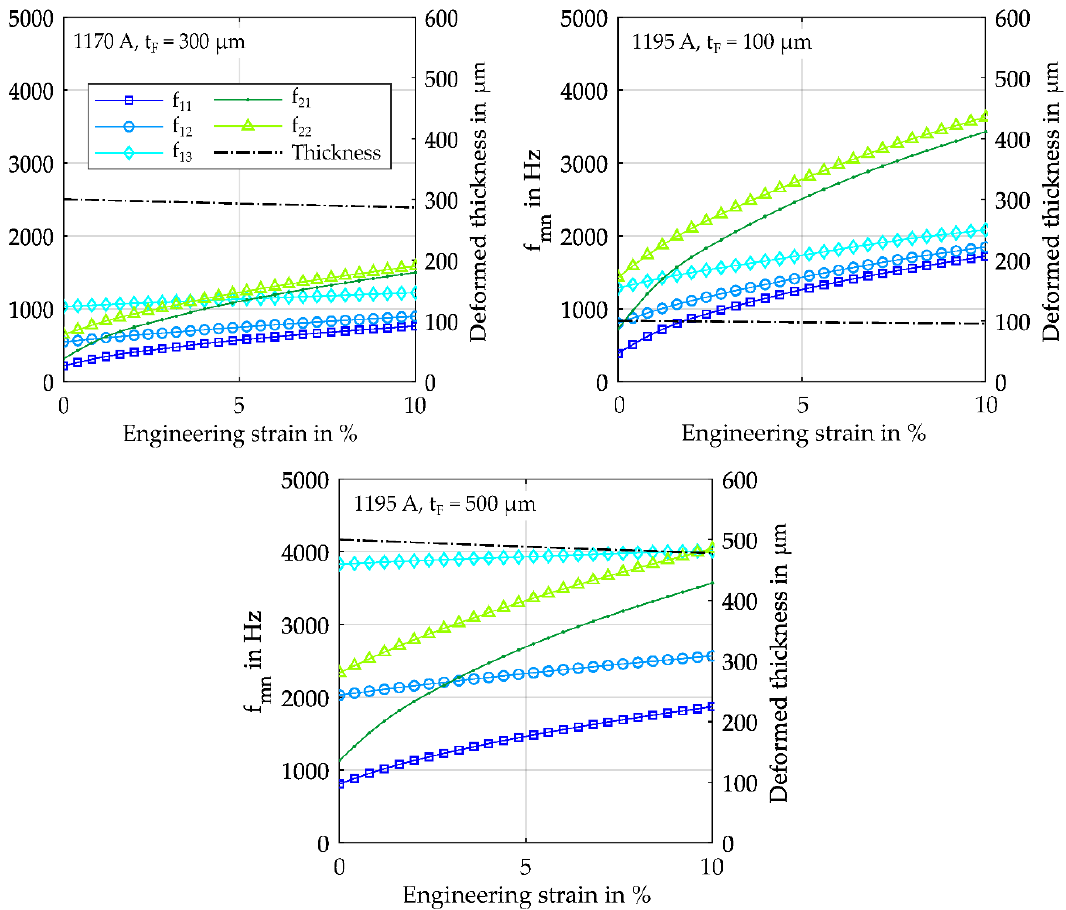
Figure 4. Numerical analysed influence of pre-stress on the vibration behaviour of polymer films.